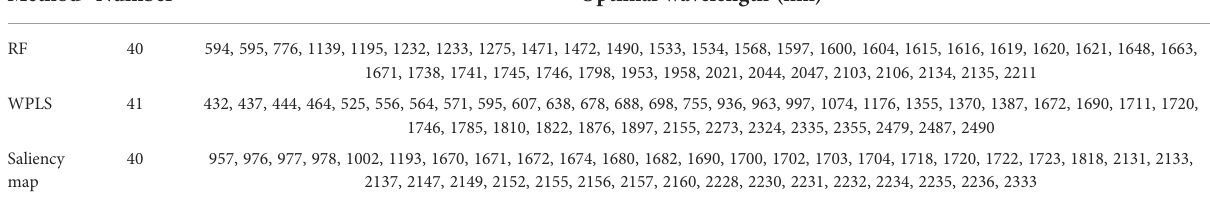
TABLE 3 The optimal wavelengths selected by RF, WPLS, and saliency map for classi fi cation models. Method Number